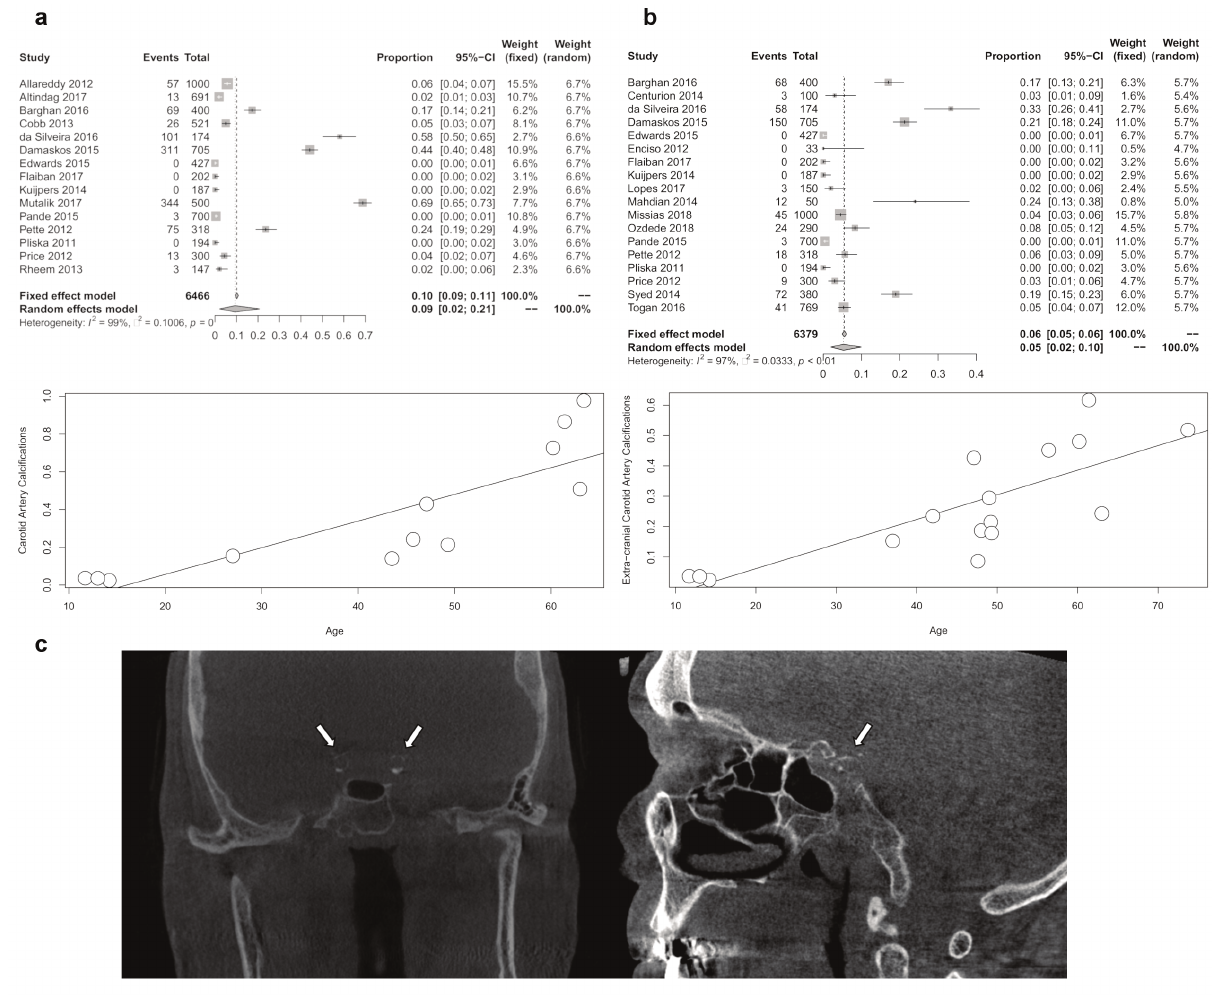
Figure 1: Meta-analysis on prevalence data about carotid calcifications according to their localization. Part a, upper. Forest plot of the meta-analysis on prevalence data (see Supplemental Information). An event was defined as the presence of at least one carotid calcification when data are available for both extra and intracranial. The mean fixed and random model global preva- lence are provided, together with heterogeneity. Part a, lower. Meta-regression plot of the linear relationship between the prevalence of carotid calcifications and the mean age of patients. Part b, upper. Forest plot of the meta-analysis on prevalence data (see Supplemental Information). An event was defined as the presence of at least one extracranial carotid calcification. Part b, lower. Meta-regression plot of the linear relationship between the prevalence of extracranial carotid calcifications and the mean age of patients. Part c. Carotid artery calcifications (white arrows) discovered incidentally in the supra-cavernous section of the internal carotid artery of a 60-year-old man. The patient was referred to his family